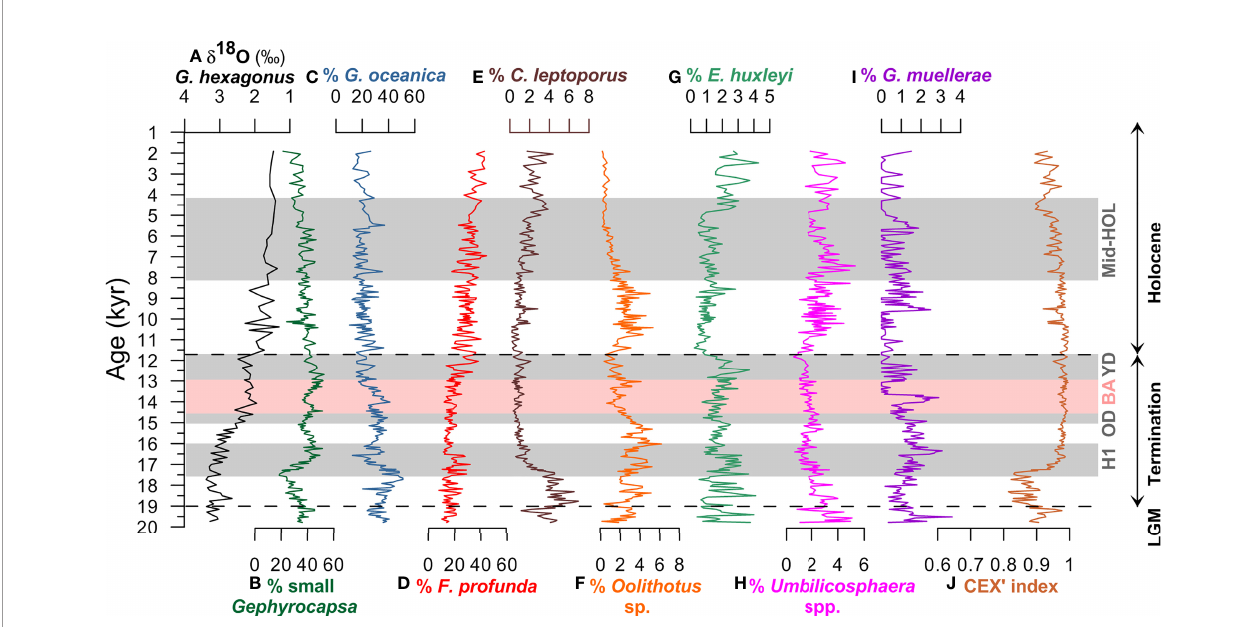
FIGURE 8 | (A) Downcore d 18 O ( ‰ ) record from the planktonic foraminifera Globorotaloides hexagonus (Max et al., 2017; Rippert et al., 2017), relative abundances of the most important coccolithophore species (>1% on average): (B) small Gephyrocapsa , (C) Gephyrocapsa oceanica , (D) Florisphaera profunda , (E) Calcidiscus leptoporus , (F) Oolithotus sp., (G) Emiliania huxleyi , (H) Umbilicosphaera spp., (I) Gephyrocapsa muellerae , and (J) CEX ’ at ODP Site 1240 between 20-1.9 kyr. Shaded areas indicate the Heinrich 1 (H1), Older Dryas (OD), Bølling – Allerød (BA) and Younger Dryas (YD) time intervals. Dashed lines indicate the limits between the Last Glacial Maximum (LGM)-Termination I, and Termination